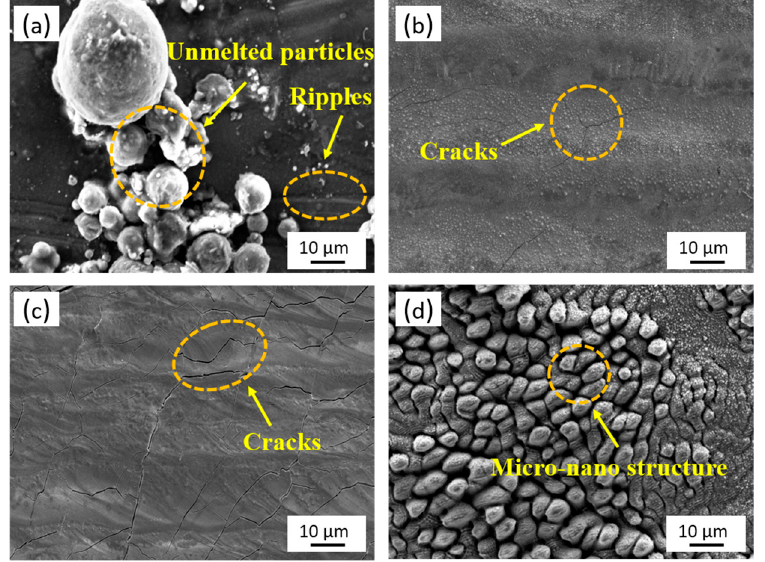
Figure 4. Surface morphologies of the ( a ) original, ( b ) CW, ( c ) NS, and ( d ) FS laser-polished 316L stainless steel surfaces.